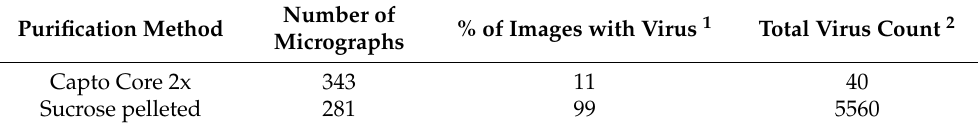
Table 2. CryoEM screening statistics of SARS-CoV-2 samples prepared by different purification methods. Purification